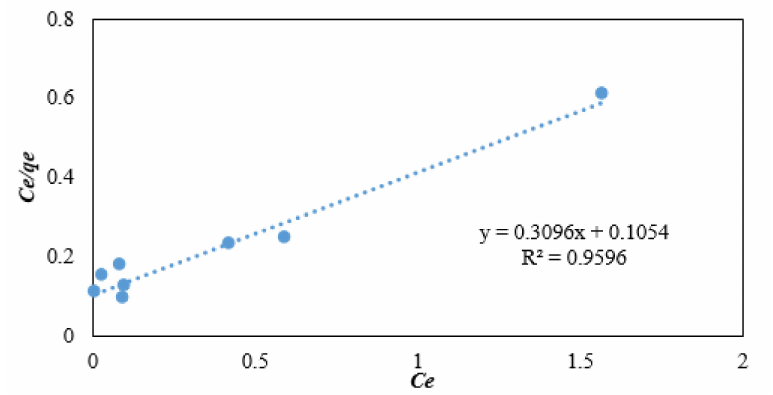
Figure 12. The Langmuir isotherm of Cr(VI) adsorption on the SDS-chitosan